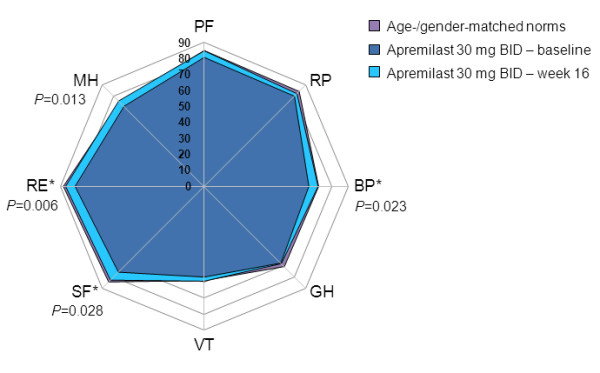
SF-36 domain scores at baseline and week 16 with apremilast 30 mg BID. Spydergram of SF-36 domain scores in patients receiving apremilast 30 mg BID versus US age-/gender-matched norms (lavender) and baseline (dark blue). Gridlines represent changes of 10 points each (10 = 2× MCID of 5 points). An increase in score indicates improvement. Treatment associated improvements (light blue) are statistically significant in four of eight domains and ≥MCID in three of eight domains. MCID, minimal clinically important difference; SF-36, 36-item Short-Form Health Survey.*≥MCID.